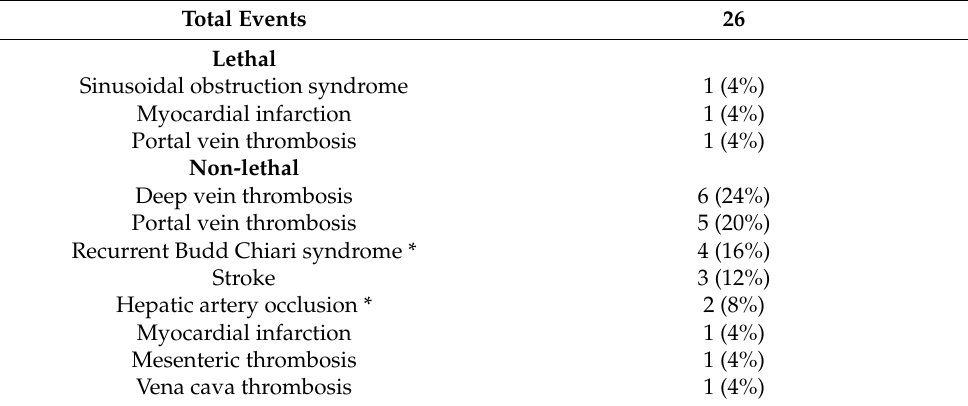
Table 2. Venous and arterial occlusion events post transplantation, n